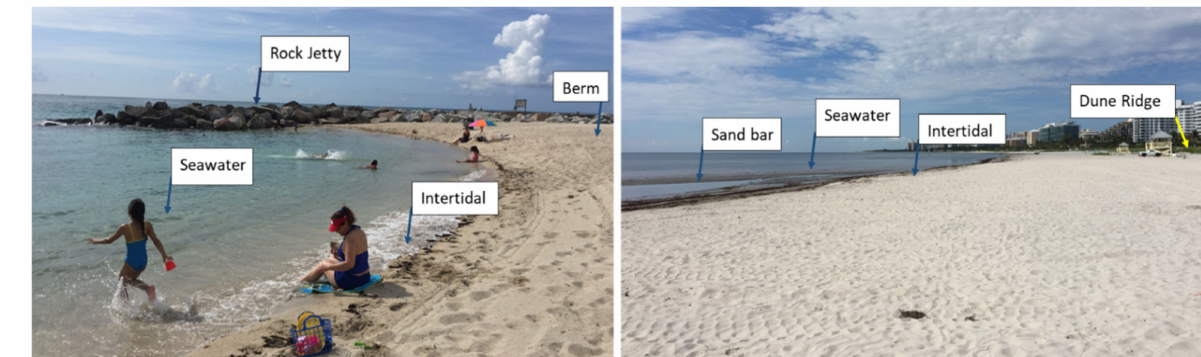
Figure 2. Profile of Haulover Beach ( left ) and Crandon Park Beach ( right ) to Demonstrate Beach